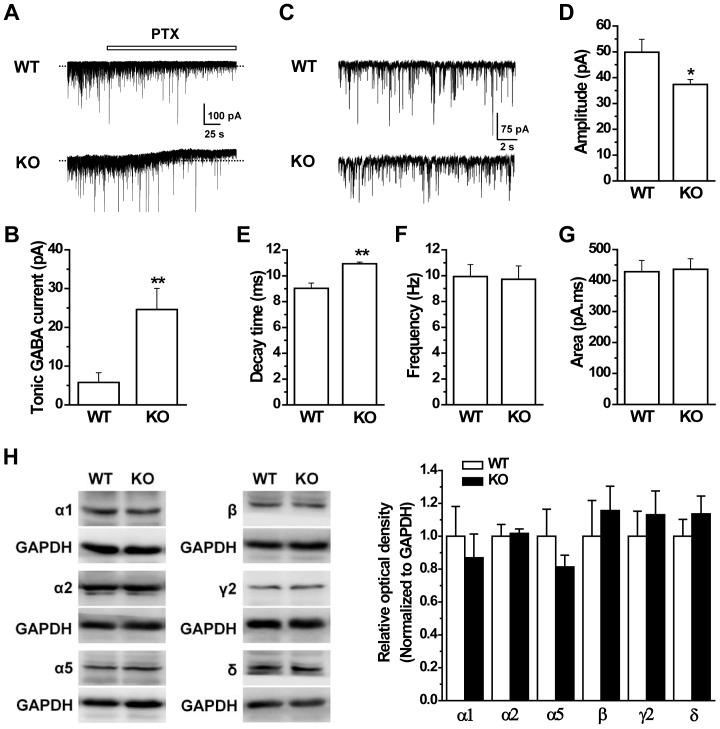
GAT1 KO mice show increased tonic GABA currents in PFC.
A, Representative traces showing the tonic GABA currents in pyramidal neurons of PFC. B, Statistical results showing that the tonic GABA current was significantly larger in GAT1 KO mice. n = 5 for each group, ** p<0.01 vs WT, t-test. C, Representative traces showing the sIPSCs in pyramidal neurons of PFC. D–G, Statistical results of the amplitude (D), decay time (E), frequency (F) and current area (G) of sIPSCs. GAT1 KO mice showed decreased amplitude but increased decay time. The frequency and current area were not significantly changed. n = 7 for each group, * p<0.05, ** p<0.01 vs WT, t-test. H, The expression of GABAA receptor α1, α2, α5, β, γ2 and δ subunits remained unchanged in the PFC of GAT1 KO mice. left, representative immunoblots; right, statistic results. n = 4–5 for each group, t-test.